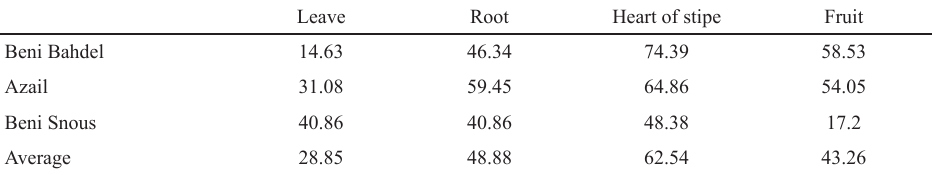
Table 3. Rate of response of use of the leaves, roots, hearts of stipe and fruits of Chamaerops humilis by the populations of the 3 surveyed municipalities.